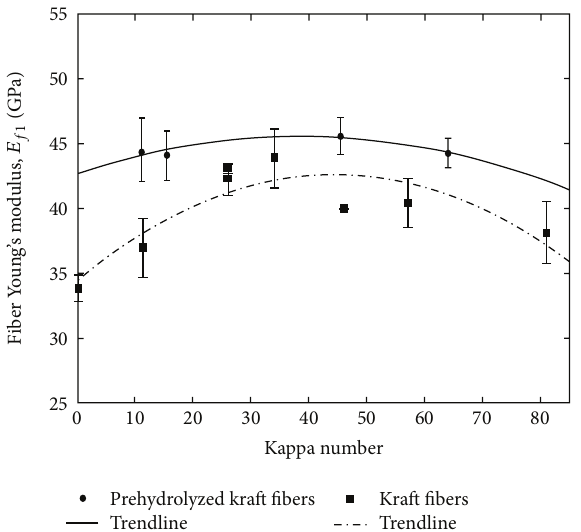
Figure 5: The effect of bleaching level, as characterized by the kappa number, on the contributing fiber stiffness in softwood fiber composites. Shown are results from laboratory softwood kraft fibers and prehydrolyzed kraft fibers